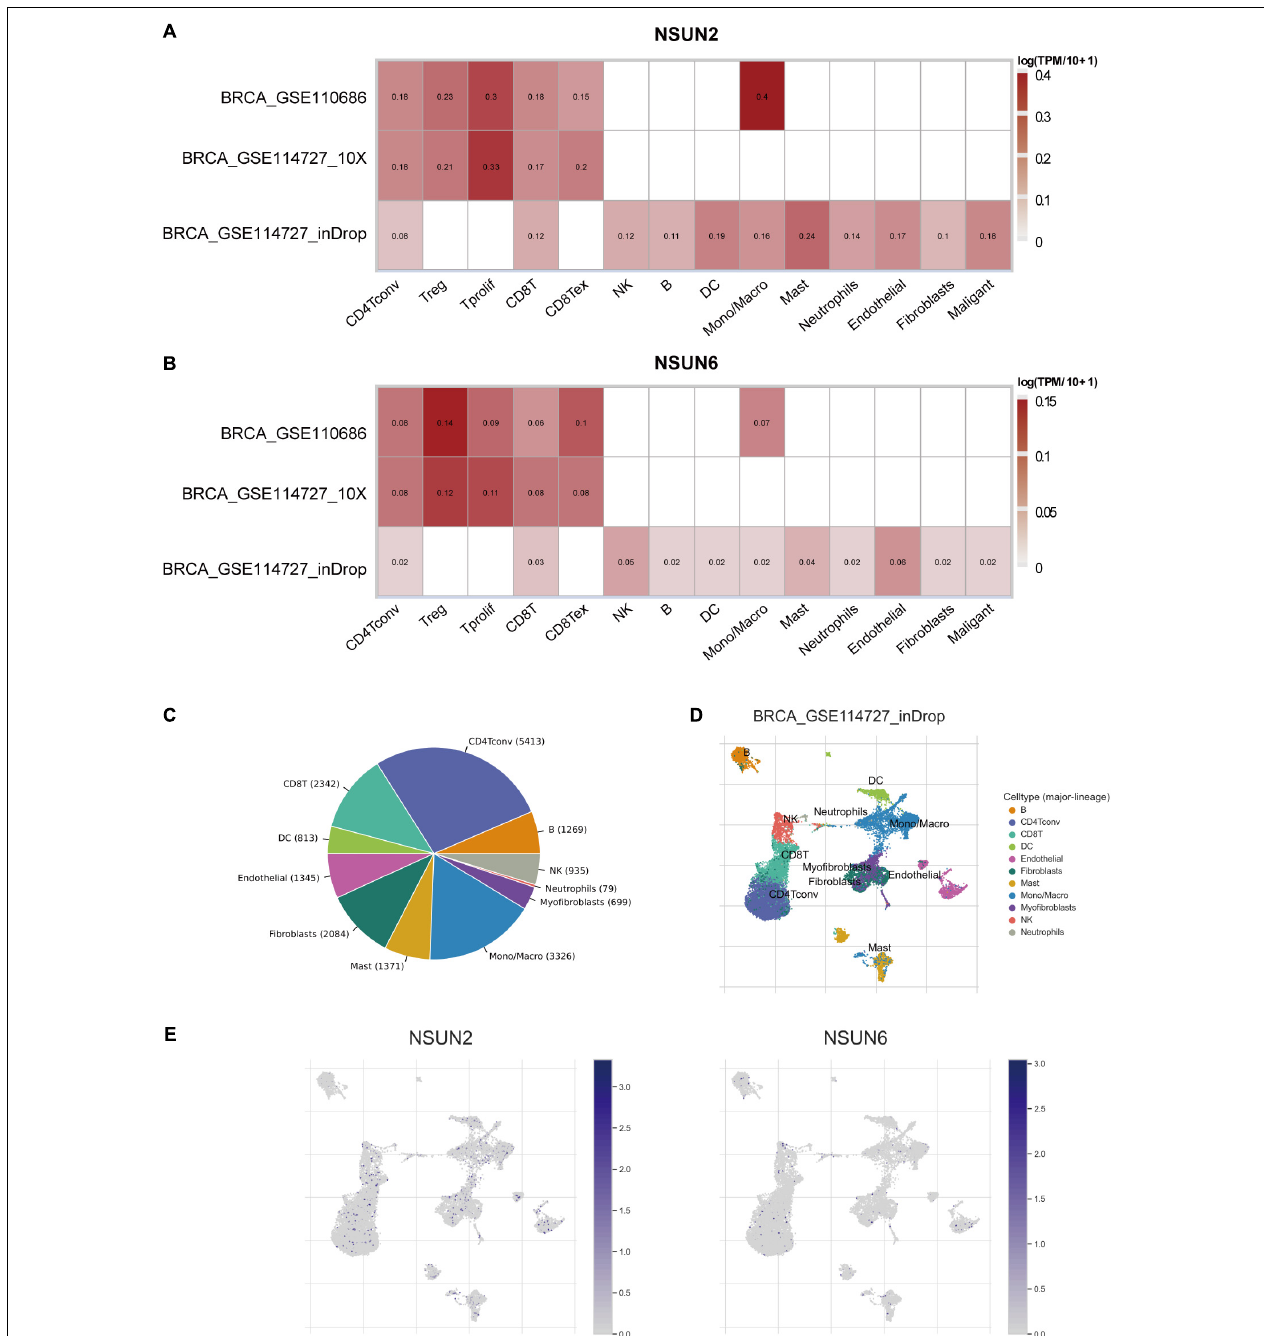
FIGURE 6 | Correlation between the prognostic-related genes and the TME. Correlation analysis between the expressions of NSUN2 and NSUN6 in primary breast cancer tissues and the TME, using the TISCH database (A,B) . The cell types and their distribution in the GSE114727_inDrop dataset (C,D) . The distribution of NSUN2 and NSUN6 in different cell types was analyzed using single-cell resolution in the GSE114727_inDrop dataset (E) . NSUN, NOP2/Sun domain family member; TME; tumor microenvironment; TISCH, Tumor Immune Single Cell